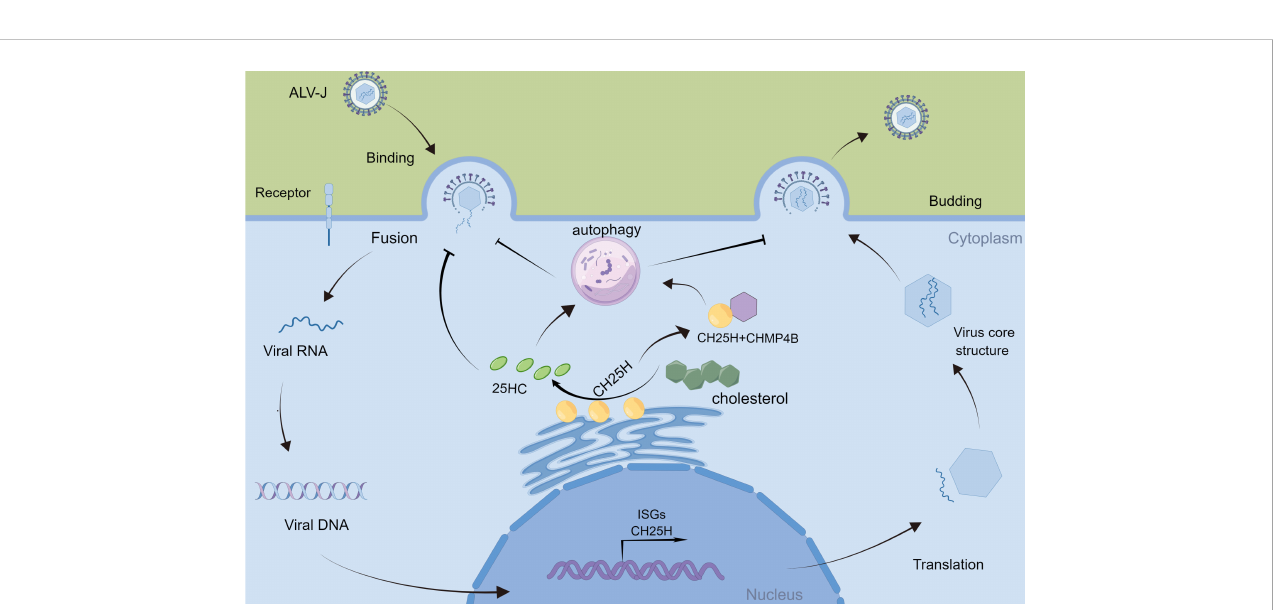
FIGURE 7 Schematic diagram of CH25H regulating ALV-J replication. ALV-J infection induces the production of Cholesterol 25-hydroxylase ( CH25H ). CH25H catalyzes the enzymatic oxidation of cholesterol to 25-hydroxycholesterol (25HC). CH25H and 25HC promote cellular autophagy, which in turn inhibits ALV-J. In addition, CH25H inhibits ALV-J by interacting with CHMP4B and promoting autophagy.